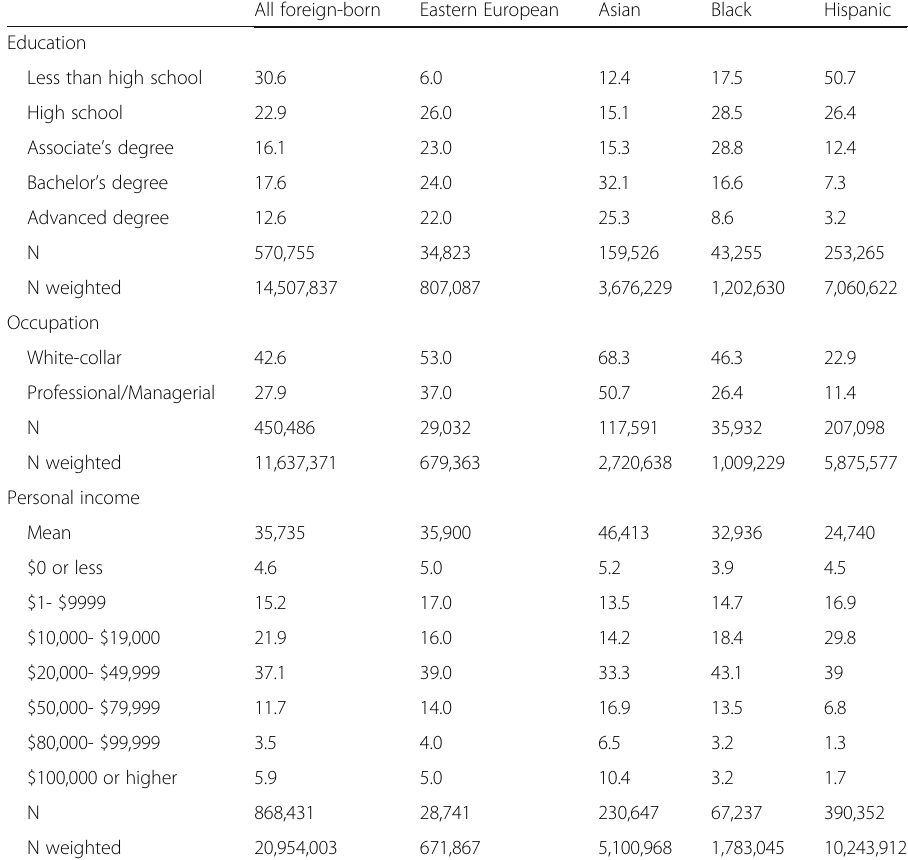
Table 2 Percentage distributions in education, occupational attainment, and personal income of post-1991 Eastern European immigrants and various foreign-born groups, 2006 – 2009 ACS All foreign-born Eastern